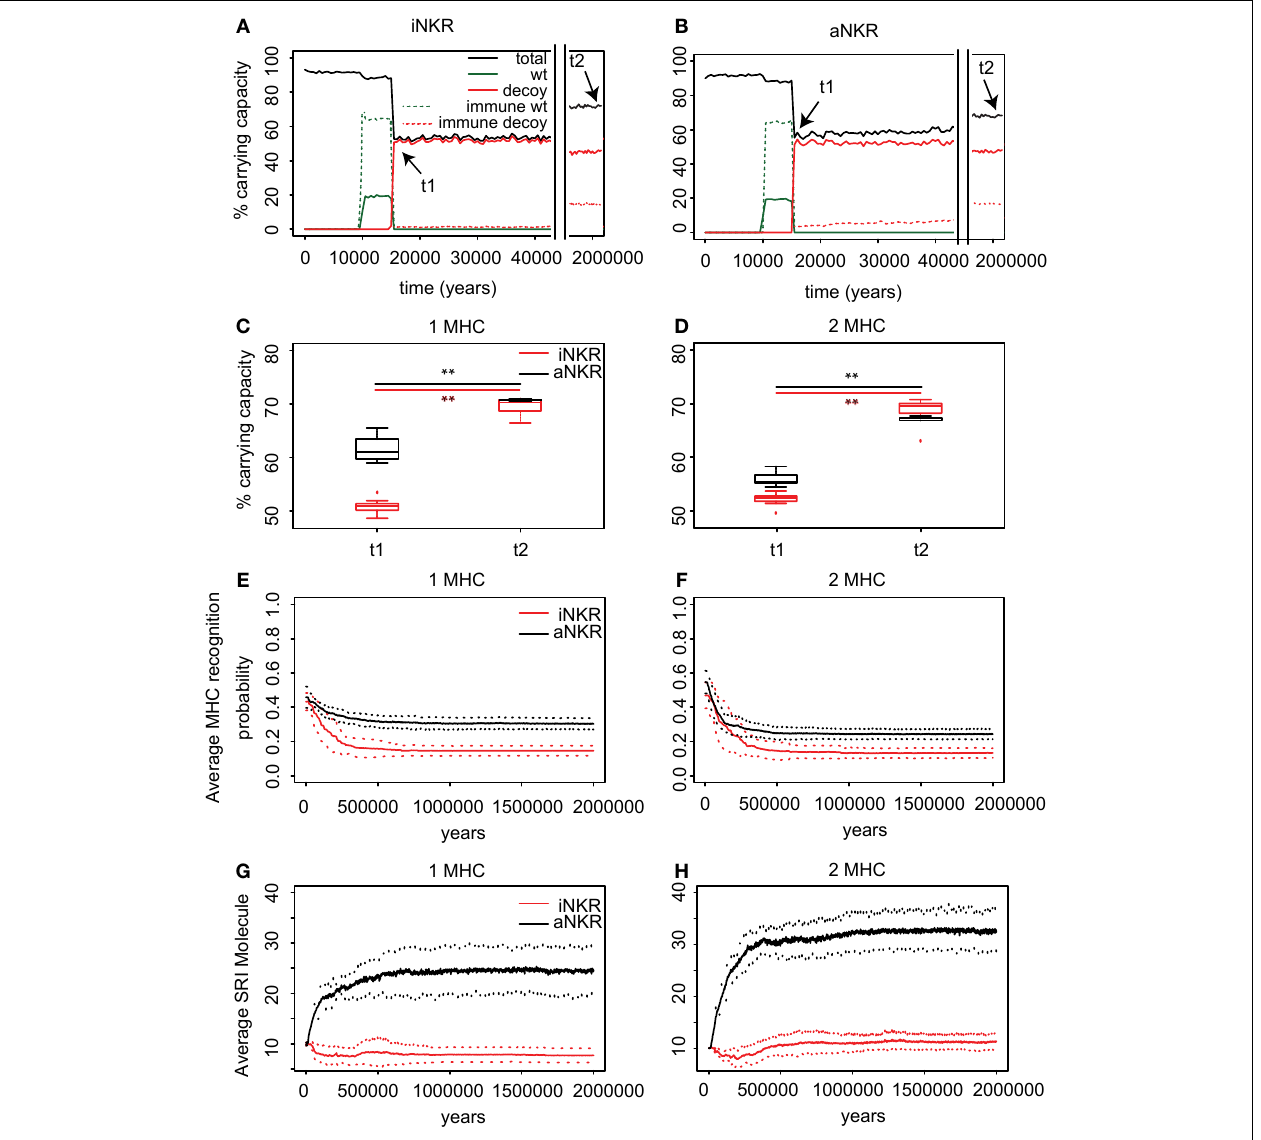
considering only aNKRs (black) are initially better protected than those in simulations considering only iNKRs (red). In these simulations, all hosts carry only one MHC locus. (D) The initial advantage that aNKRs have over iNKRs receptors decreases in simulations considering two MHC loci per individual. (E) The probability of iNKRs recognizing any random MHC molecule in the population decreases over time (red line), indicating that more specific receptors are being selected for. In contrast, aNKRs (black line) do not evolve such high degree of specificity. (F) aNKRs evolve to become more specific in simulations where individuals have two MHC loci. (G) The degree of NKR polymorphism (expressed as the SRI score) increases in time, as a result of the evolved higher specificity. (H) SRI score in simulations considering two MHC loci. In (C,D) , the boxes represent the interquartile range, and the thick horizontal lines the median out of ten simulations (**represent p values < 0.005 and were calculated using the Mann–Whitney U test). In (E–H) , the solid lines represent the average out of ten simulations, and the dashed lines are the standard